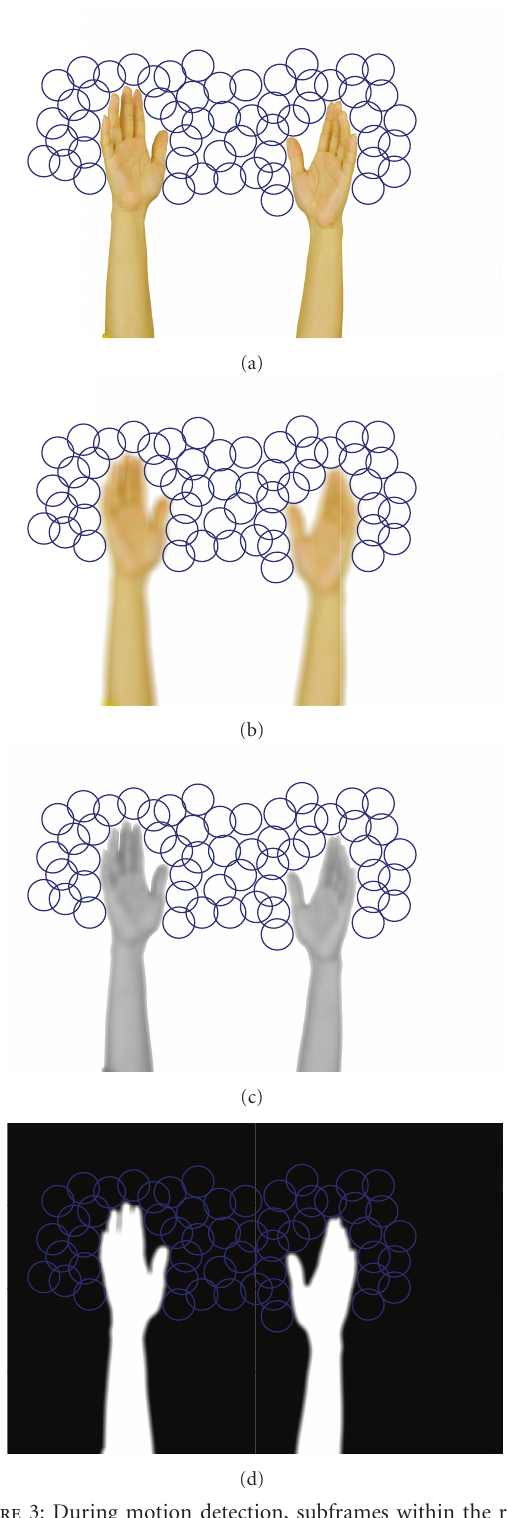
Figure 3: During motion detection, subframes within the region of interest are captured (a), blurred (b), and converted to shades of gray (c). In the areas of the subframe indicated by circles, the pixels changing between consecutive captures (d) comprise a direct measurement of motion. Such pixel changes are repeatedly summed and compared with a predefined threshold value. At a given time in a given area, if the threshold value is exceeded, motion is